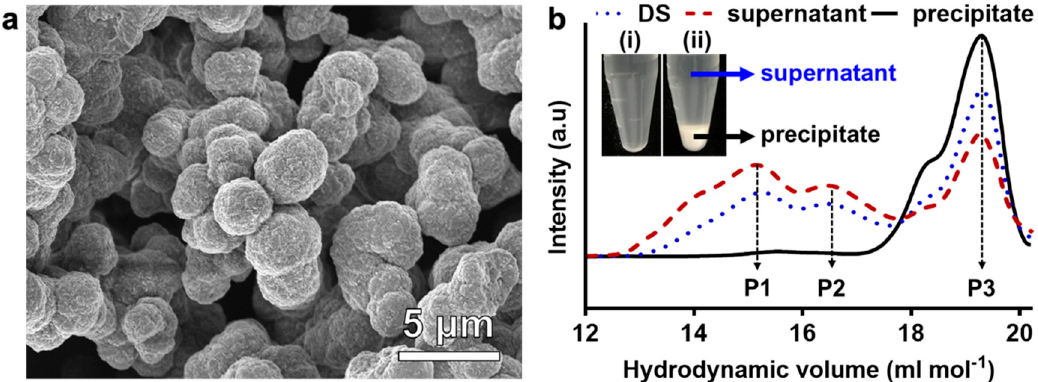
Figure 4. ( a ) Scanning electron microscopy (SEM) image of the white precipitate obtained by freezing the debranched starch solution at –20 °C for 5 min. ( b ) Molecular size distribution of glucan molecules after full debranching reaction (dotted line) and its supernatant (dashed line) and precipitate (solid line), measured by gel permeation chromatography (GPC). Inset shows a photographic image of the reaction tubes after debranching (i) and cooling at − 20 °C for 5 min (ii). The debranching reaction was carried out with 0.1 mg/mL native waxy maize starch and 1 ASPU/mL of pullulanase for 1 h. The white precipitate is self-aggregated SCG molecules at − 20 °C.